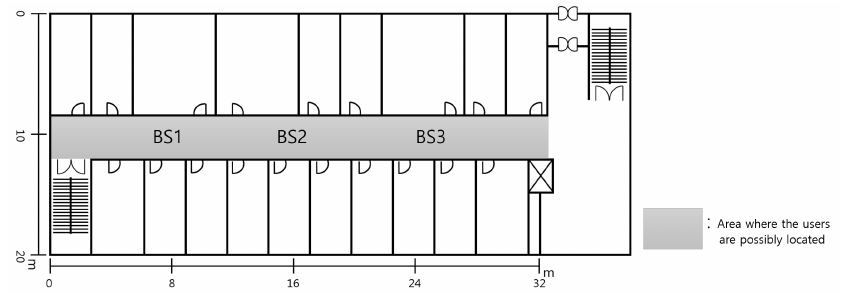
Figure 5. User area (shaded) and base station (BS) location in line-of-sight (LoS)